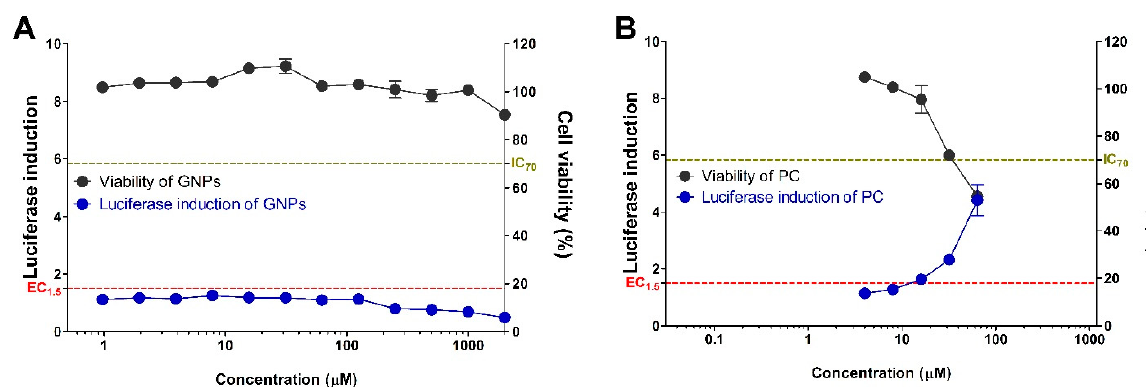
Figure 2. Induction of luciferase activity (blue line) and viability (black line) in the KeratinoSens TM assay. The cells were treated with the ( A ) graphene nanoplatelets (GNPs), and ( B ) positive control (cinnamic aldehyde, CAS number 14371-10-9). Data are expressed as mean ± SEM ( n = 6). Positive control was tested in parallel (4–64 µM). Table 3. GNPs evaluated in KeratinoSens TM assay.